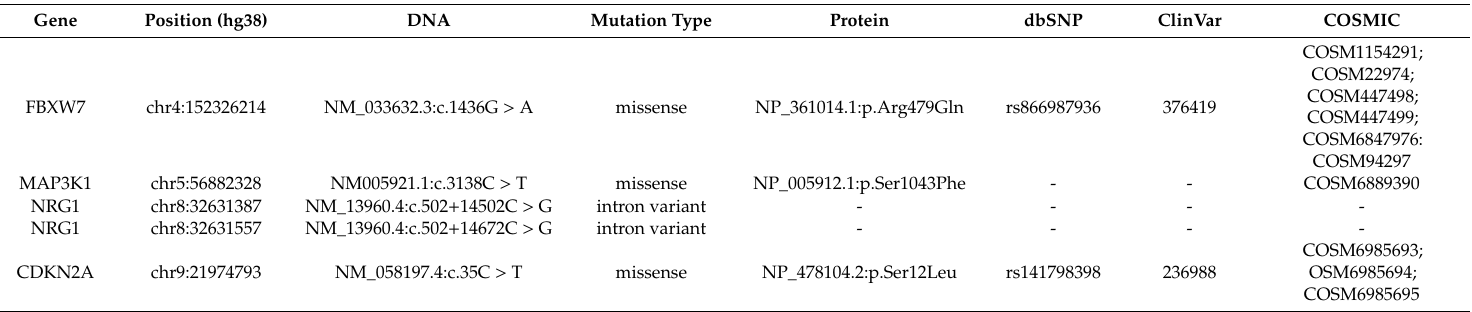
Table 1. Summary of the validated mutations.